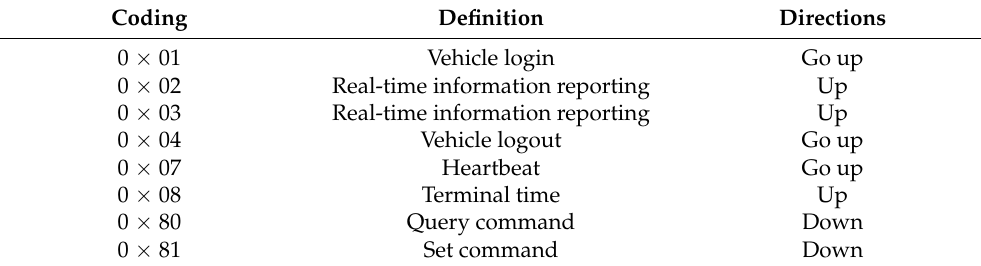
Table 2. Command